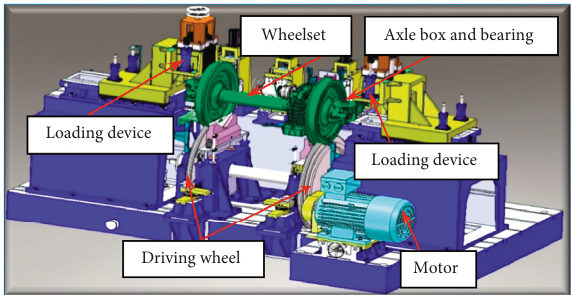
Figure 21: Schematic sketch of the wheelset-bearing test